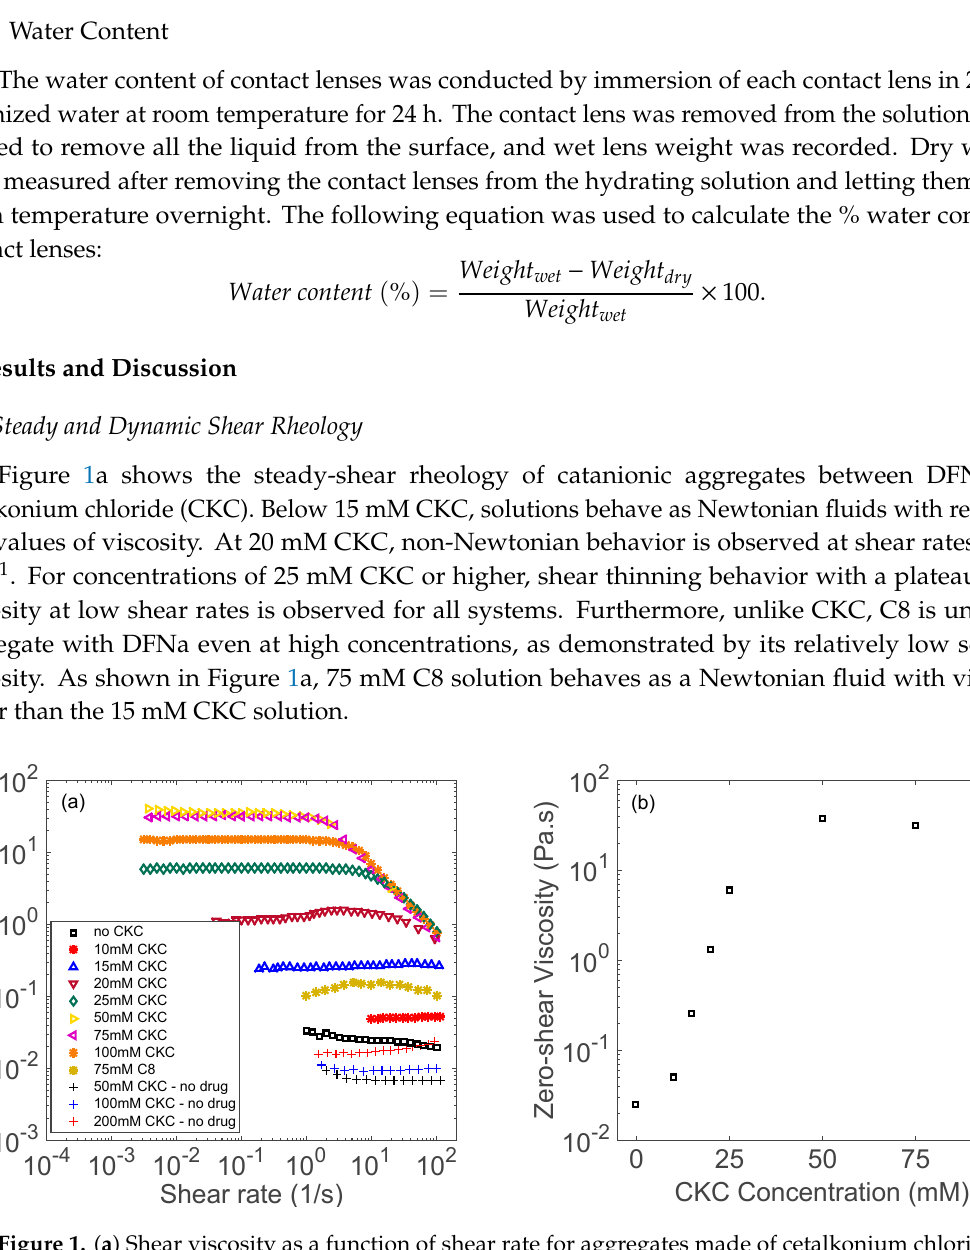
Figure 1. ( a ) Shear viscosity as a function of shear rate for aggregates made of cetalkonium chloride (CKC) and diclofenac sodium (DFNa). ( b ) Zero-shear viscosity as a function of CKC concentration. Measurements were performed at room temperature and at a fixed concentration of diclofenac sodium (30 mM) and Brij 97 (20 wt%).